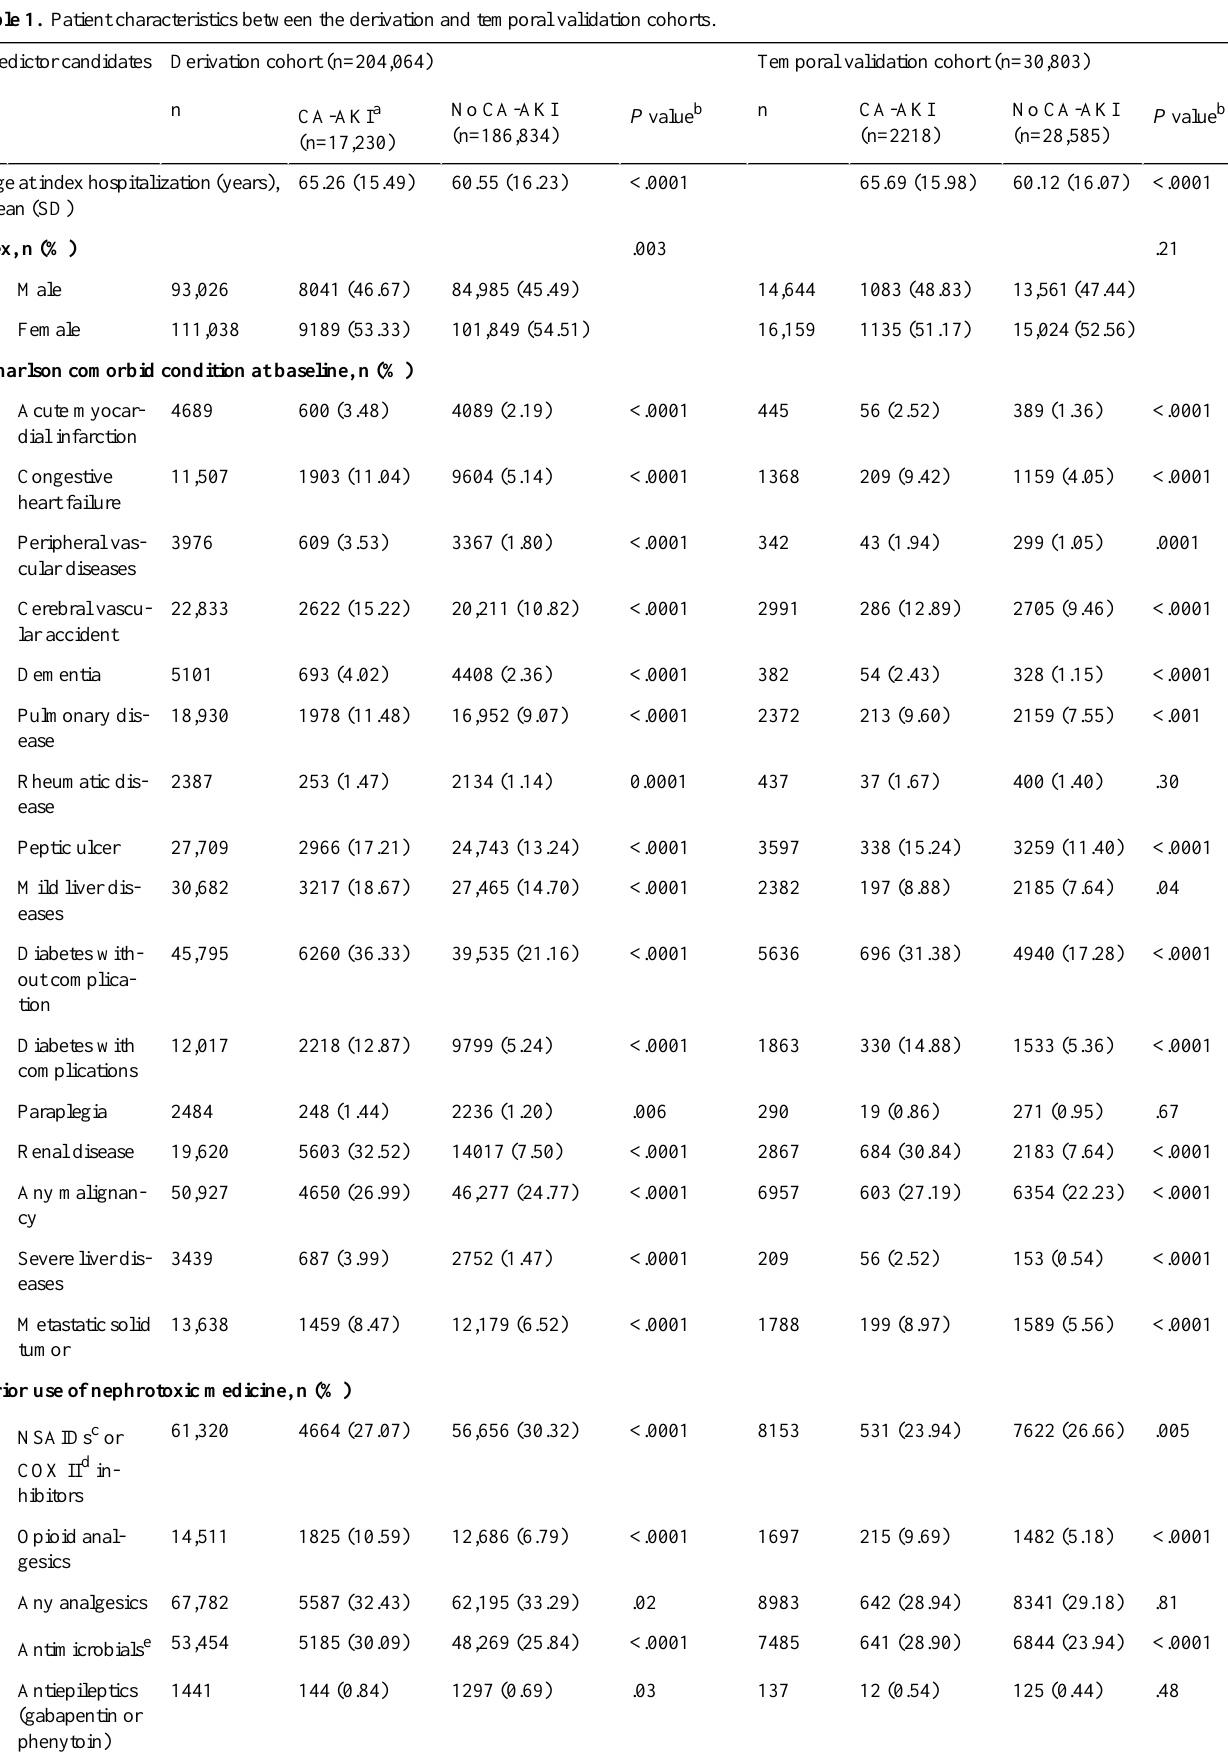
Table 1. Patient characteristics between the derivation and temporal validation